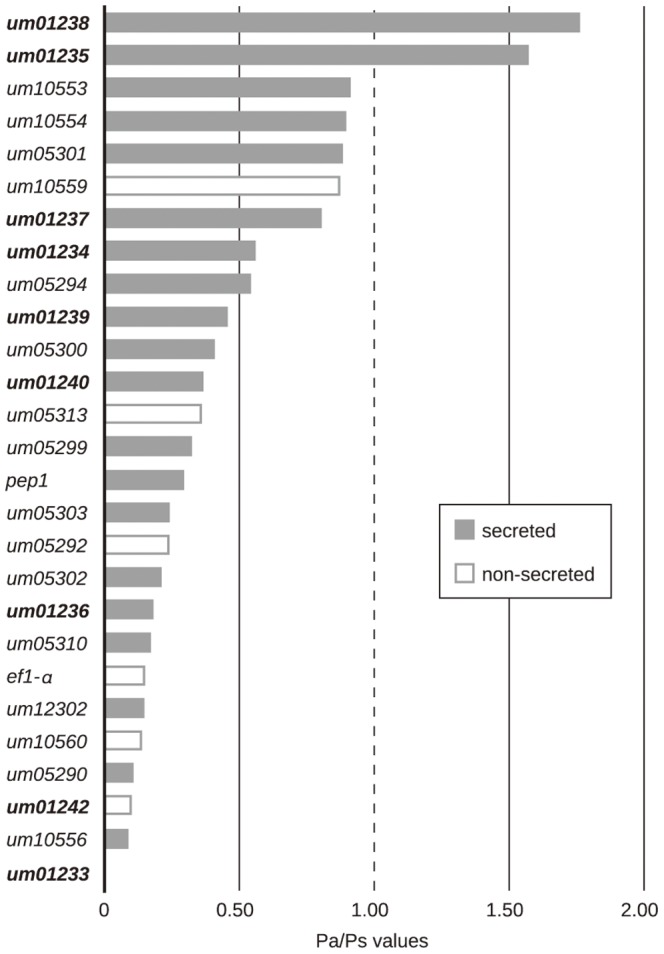
Ratios of Pa and Ps.Listed are all genes that contain non-synonymous and synonymous mutations. Grey bars indicate putatively secreted protein-coding genes and white bars indicate putatively non-secreted protein-encoding genes. Bold um gene numbers represent genes of cluster 2A. Light um gene numbers represent genes of cluster 19A.